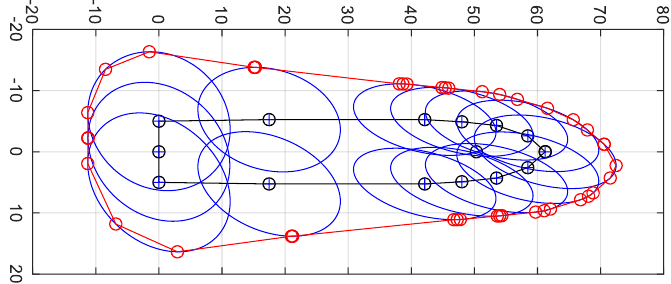
Figure 7. Example of MVPA visualization [m] for 2° heading error of m/v “Nawigator XXI”